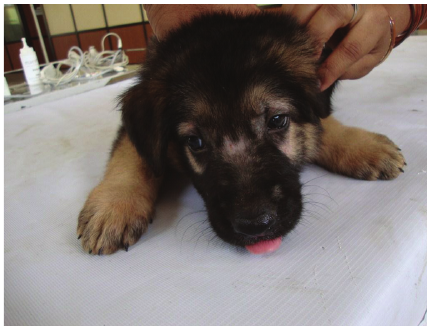
Figure 1: Dog with lesions at face and neck regions (Case 1).